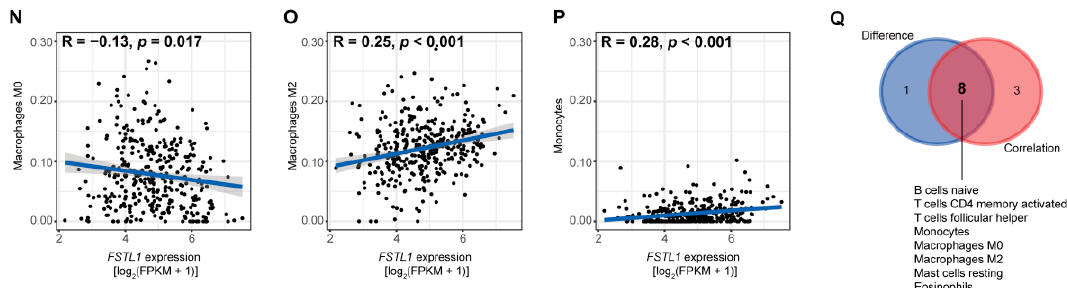
Figure 6. FSTL1 was related to immune infiltration in the TME of GC patients. After GC patients from TCGA were divided into high- and low-score groups (50% each) according to the stromal, immune, and ESTIMATE scores, the expression levels of COL5A1 ( A – C ) and FSTL1 ( D – F ) in the two groups were compared. Correlation analyses between COL5A1 ( G – I ) or FSTL1 ( J – L ) and the stromal, immune, and ESTIMATE scores. ( M ) GC patients from the TCGA were divided into high or low groups (50% each) according to the expression level of FSTL1, and the proportions of 22 types of immune cells in the two groups were then estimated by the CIBESORT algorithm. Correlation analyses between FSTL1 and the content of monocytes ( N ), M2 macrophages ( O ), and M0